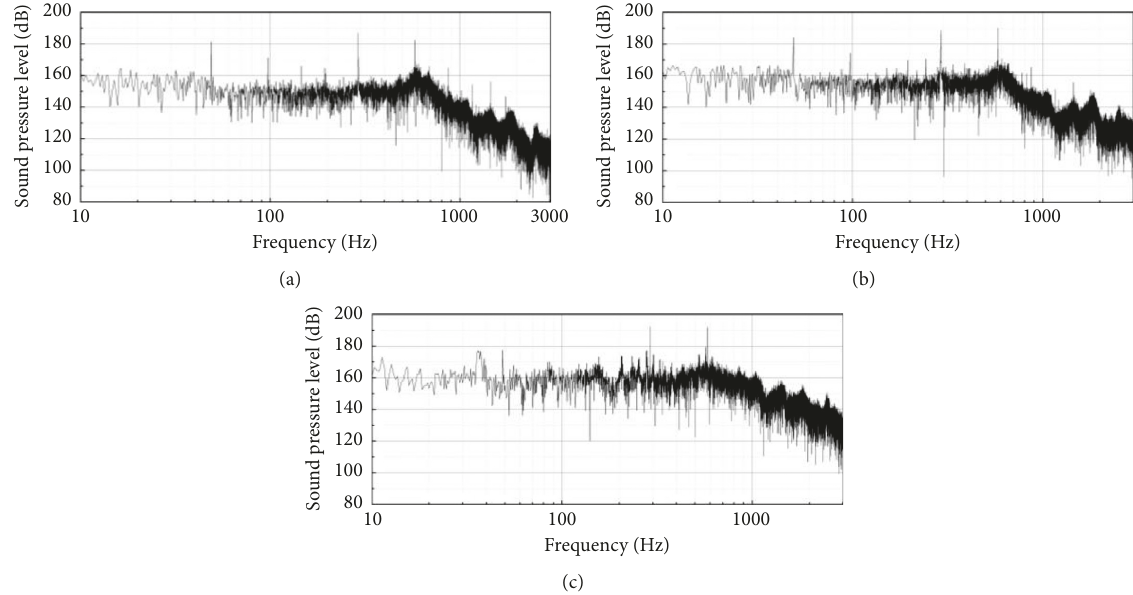
0.048; (b) inception cavitation stage (cid:28)